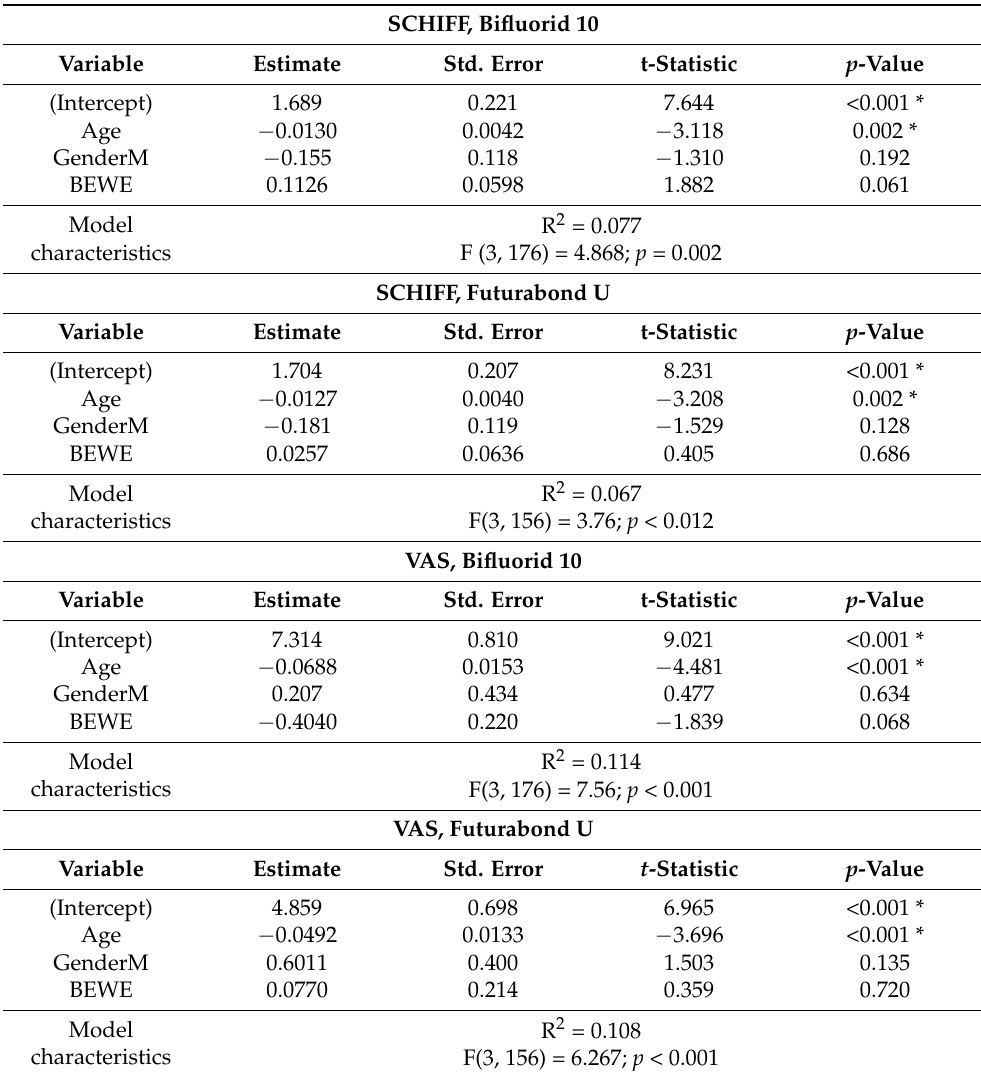
Table 3. Regression analysis of total pain reduction in both groups according to SCHIFF and VAS